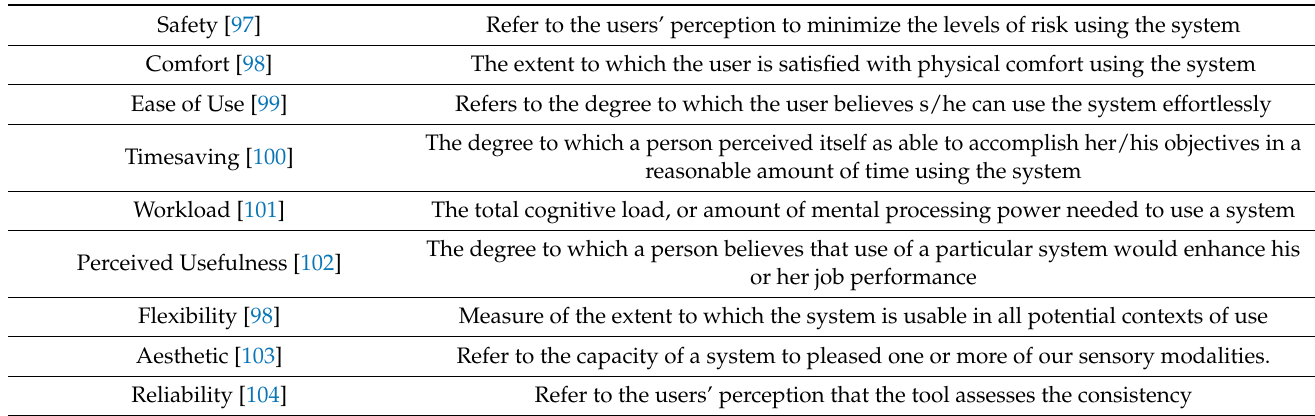
Table 2. UX constructs emerging from the study previously explored in the